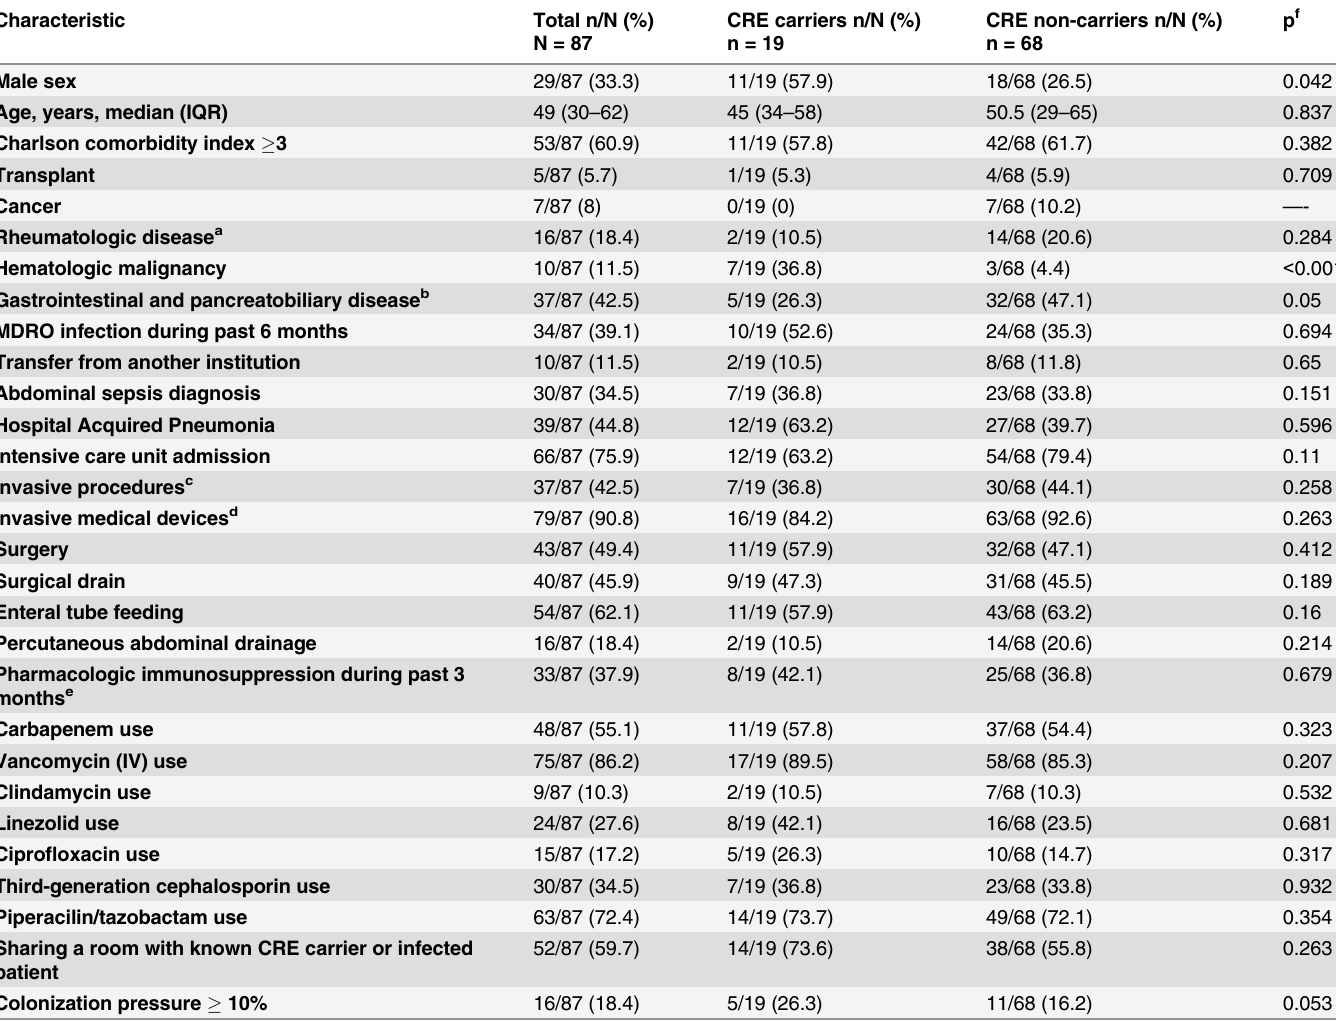
Table 4. Characteristics Associated to Carbapenem-Resistant Enterobacteriaceae Fecal Carriage Incidence.